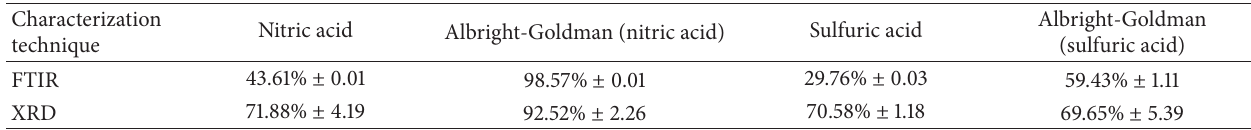
Table 4: The crystallinity indices for the neat nitric and sulfuric acid extracted samples and their Albright-Goldman oxidized counterparts.